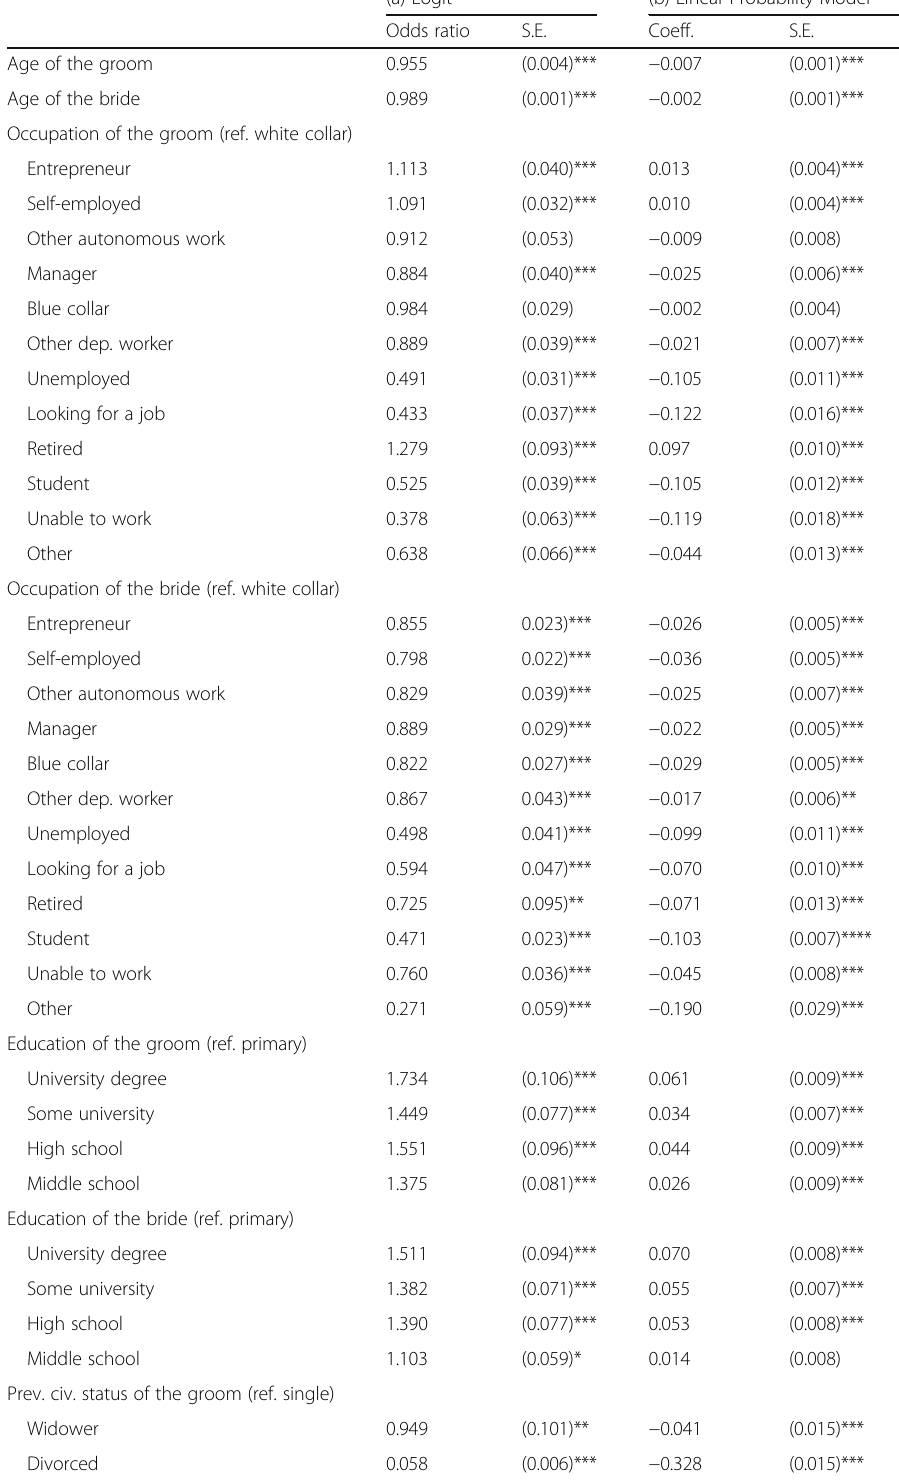
Table 4 Socio-demographic characteristics associated with the choice of marrying with the religious rite: results from a multivariate logistic regression. Italy, 2007 –